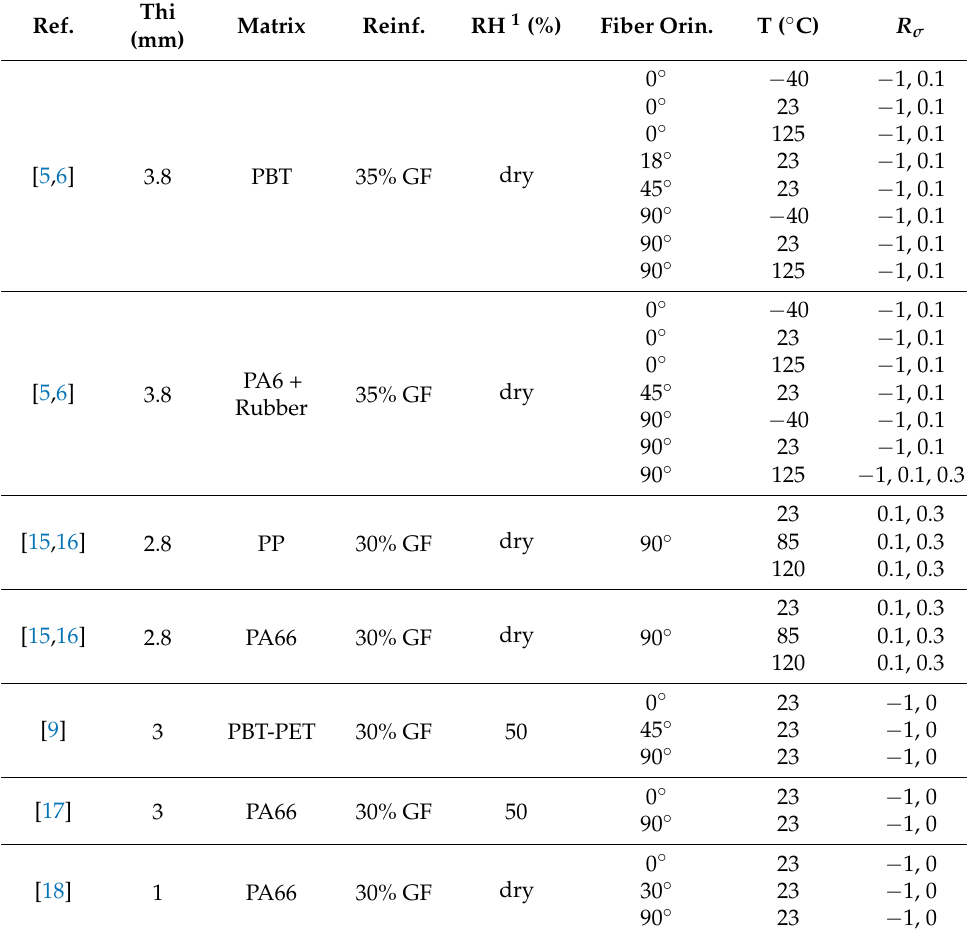
Table 2. Literature data sets for un-notched uniaxial fatigue behavior of injection-molded short glass fiber composites. Fiber diameter is 10 µ m. The fiber aspect ratio (fiber length/fiber diameter) range is